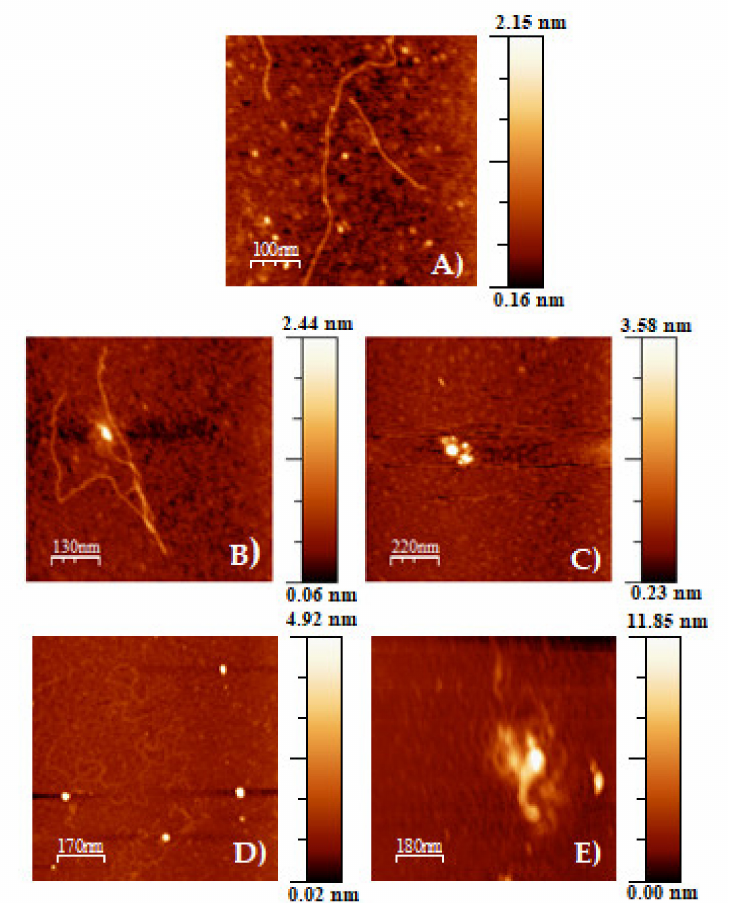
Figure 6. AFM topographic images of CAL/DOPE/DNA lipoplexes in buffered solutions, 10 mM HEPES (pH = 7.4), adsorbed on APTES modified mica surface. ( A ) Pure DNA; ( B ) (Im 3 Im 16 ) 2 α = 0.2 and L/D = 1; ( C ) (Im 3 Im 16 ) 2 α = 0.2 and L/D = 7; ( D ) (TEAC 12 ) 4 α = 0.2 and L/D = 1; ( E ) (TEAC 12 ) 4 α = 0.2 and L/D =